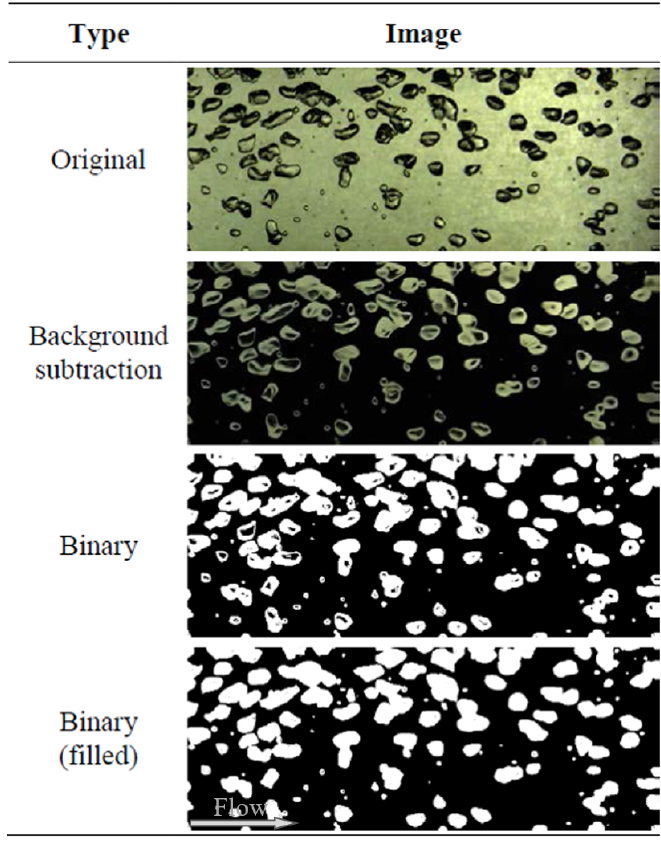
Figure 10. Binarization process of the RGB image into a binary image. The arrow indicates the direction of the free-stream velocity vector.